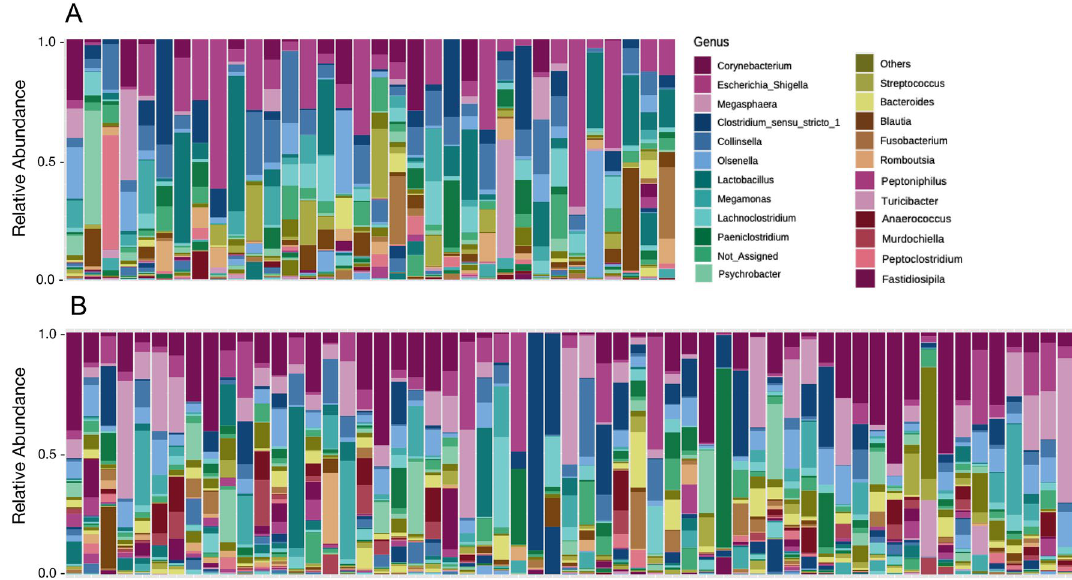
Figure 4. Relative abundance bar plots at genus level showing extent of interindividual variation among polar bears in the ( A ) East Greenland (EG) and ( B ) Southern Beaufort Sea (SB) subpopulations.